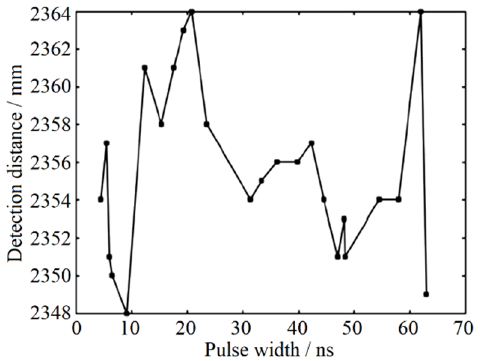
Figure 7. Ranging results after gray-value distance